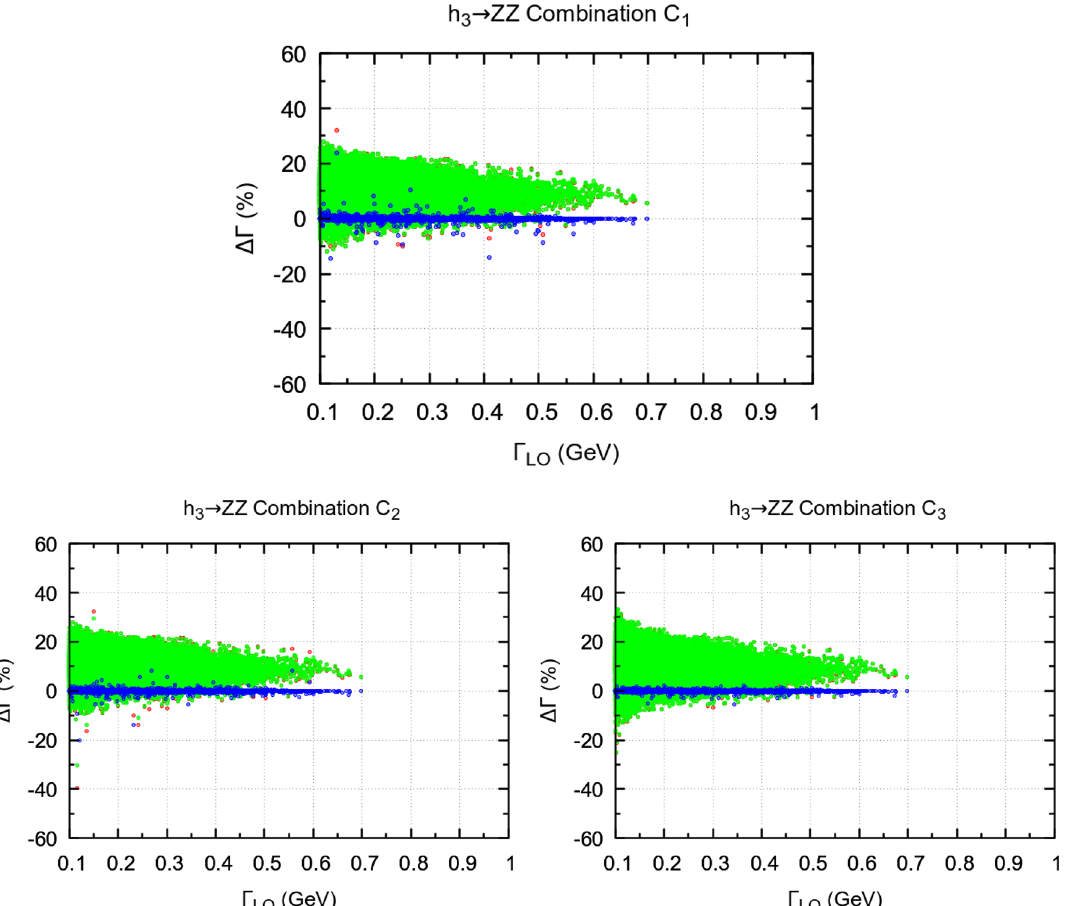
Figure 4. ∆Γ h in percentage against Γ LO , for the combinations C 1 (top), C 2 (bottom h 3 → ZZ 3 → ZZ left) and C 3 (bottom right). For C 1 , we impose the cuts π/ 2 − | α 3 | > 0 . 0005 and | α 3 | > 0 , whereas for C 2 and C 3 we impose the cuts π/ 2 − | α 3 | > 0 . 005 and | α 3 | > 0 . Only the interval ; in blue, 0 . 1 GeV < Γ LO < 1 GeV is shown. In red, ∆Γ h ; in green, Γ mix / Γ LO h 3 → ZZ h 3 → ZZ h 3 → ZZ 3 → ZZ Γ m 3 / Γ LO . According to eq. (4.5), the red points are the sum of the green and the blue h 3 → ZZ h 3 → ZZ